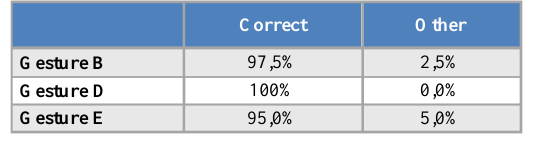
Table 4. Success rate for the recognition of several gestures with a manually selected